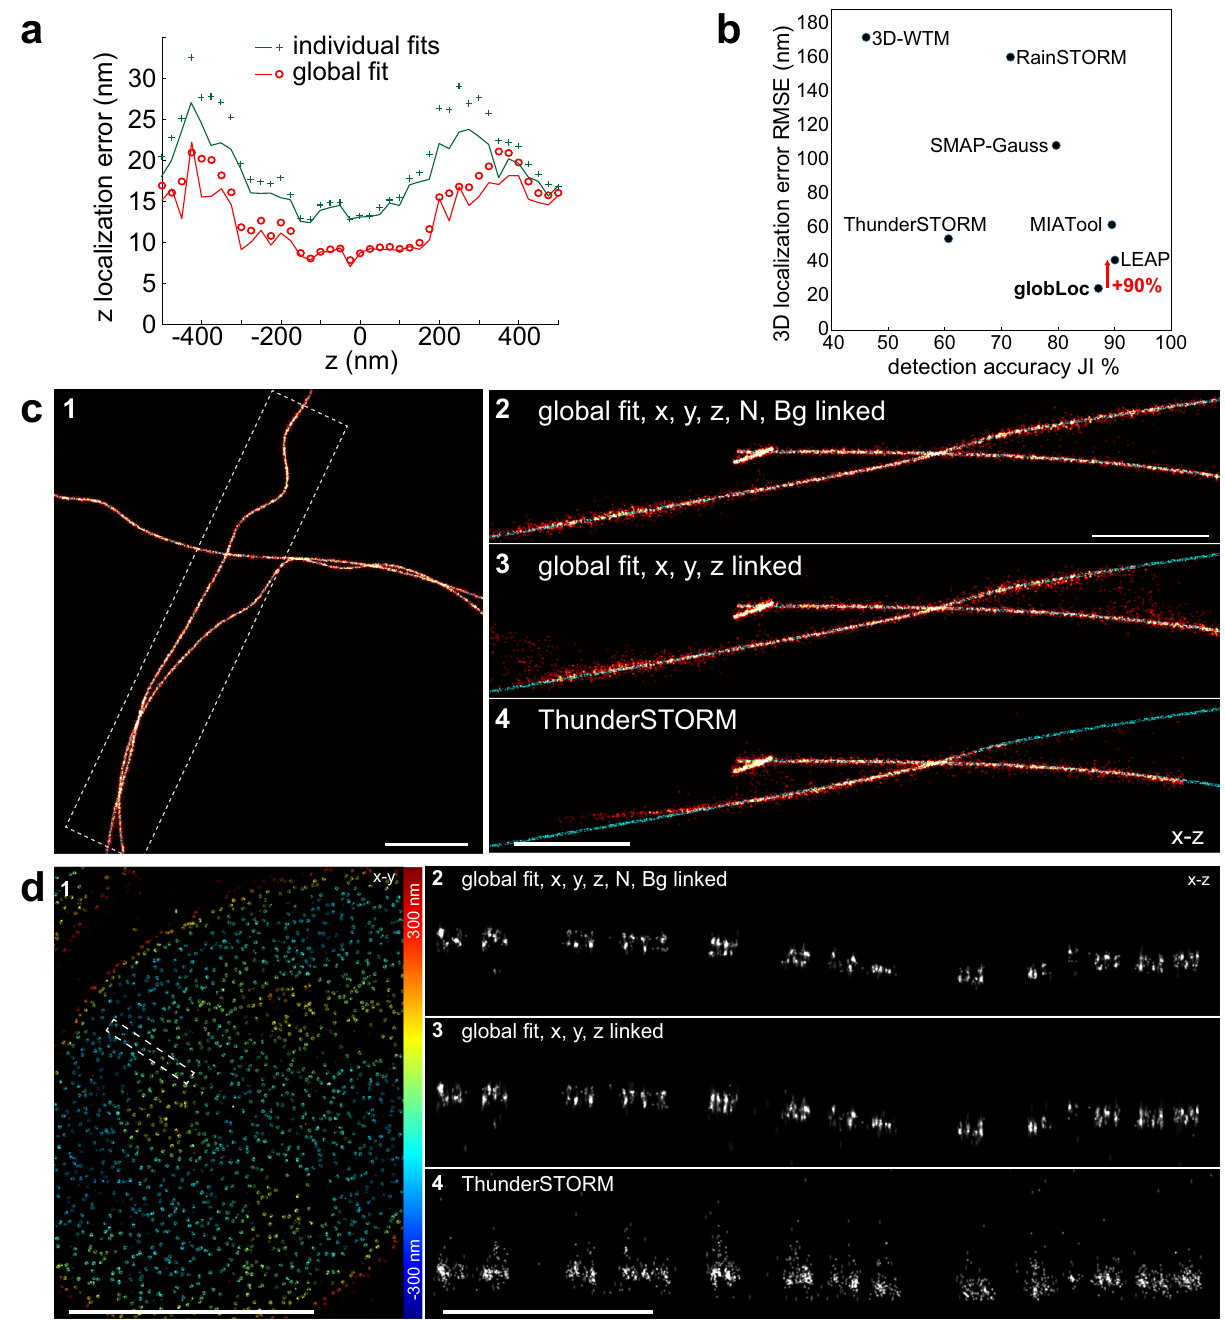
Fig. 2 Performance of globLoc on biplane data. a Comparison of the z localization error using globLoc and using single-channel fi tting followed by CRLB- ffiffiffiffiffiffiffiffiffiffiffi p weighted averaging of positions. GlobLoc improved both the minimum theoretical localization uncertainty ( CRLB , line) and the localization error (RMSE, circles) by approx. 1.5-fold compared to individual fi tting ( + , Supplementary Fig. 1). Simulations based on the biplane PSF model from the SMLM challenge 2016, 2500 detected photons in each channel and background of 20 photons per pixel. b Performance of different software on biplane data in the SMLM challenge 2016. GlobLoc (SMAP-global in the submission) outperformed all other software and improved the localization accuracy by 90% compared to the second-best algorithm LEAP 25 . c Comparison of globLoc under different parameter sharing schemes and compared to ThunderSTORM (detailed settings in Supplementary Fig. 9a) for biplane training data (MT0.N1.LD_BP) of the SMLM challenge 2016. c2-4 Side-view cross-sections of the region as indicated by the dashed white box in c1 (c2: globLoc with x, y, z , photons and background photons shared; c3: globLoc with x, y and z shared; c4: ThunderSTORM.). Red-hot: fi tted localizations; cyan: ground truth. d Comparison of globLoc on bi-plane data under different parameter sharing schemes and compared to ThunderSTORM (detailed settings in Supplementary Fig. 9b), on the example of the nuclear pore protein Nup96-AF647. d2-4 Side-view cross-sections of the region as indicated by the dashed white box in d1 (d2: globLoc with x , y , z , photons and background photons linked; d3: globLoc with x , y and z linked; d4: ThunderSTORM.). Representative results are shown from 3 experiments for d . Scale bars 1 µ m (c1, c2, d4), 10 µ m